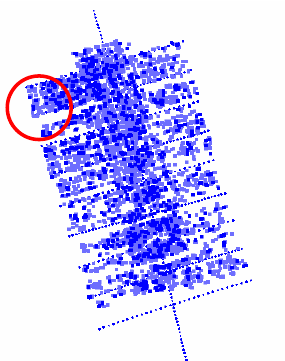
Figure 3. Display of tie planes. Roof tops within the encircled area were used for further